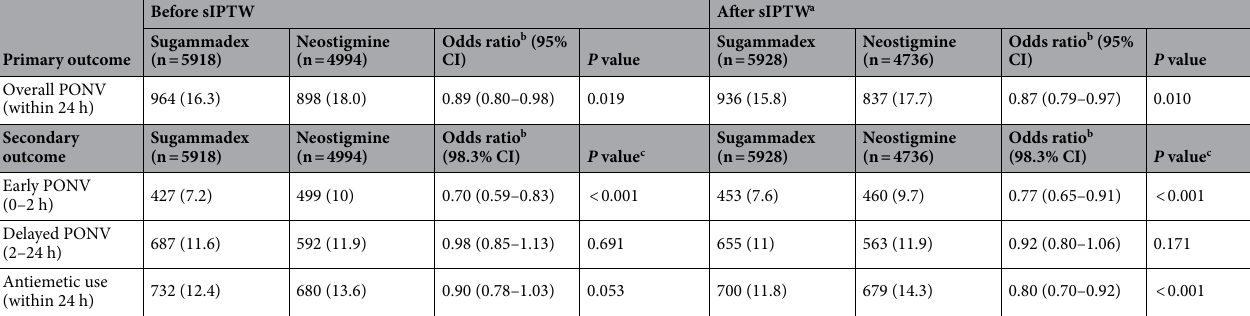
Table 2. Comparison of probability of primary and secondary outcomes between sugammadex use and neostigmine use, before and after adjusting for confounding by sIPTW, in the total cohort. CI Confidence interval, PONV Postoperative nausea and vomiting, sIPTW, stabilized inverse probability of treatment weighting. a Stabilized weights are used to adjust for confounding. b Odds ratios estimate the probability of the given outcome in patients who received sugammadex versus patients who received neostigmine for each outcome. c Statistical significance corrected by the Bonferroni correction to adjust for increased type I error by multiple testing ( P < 0.05/3 =